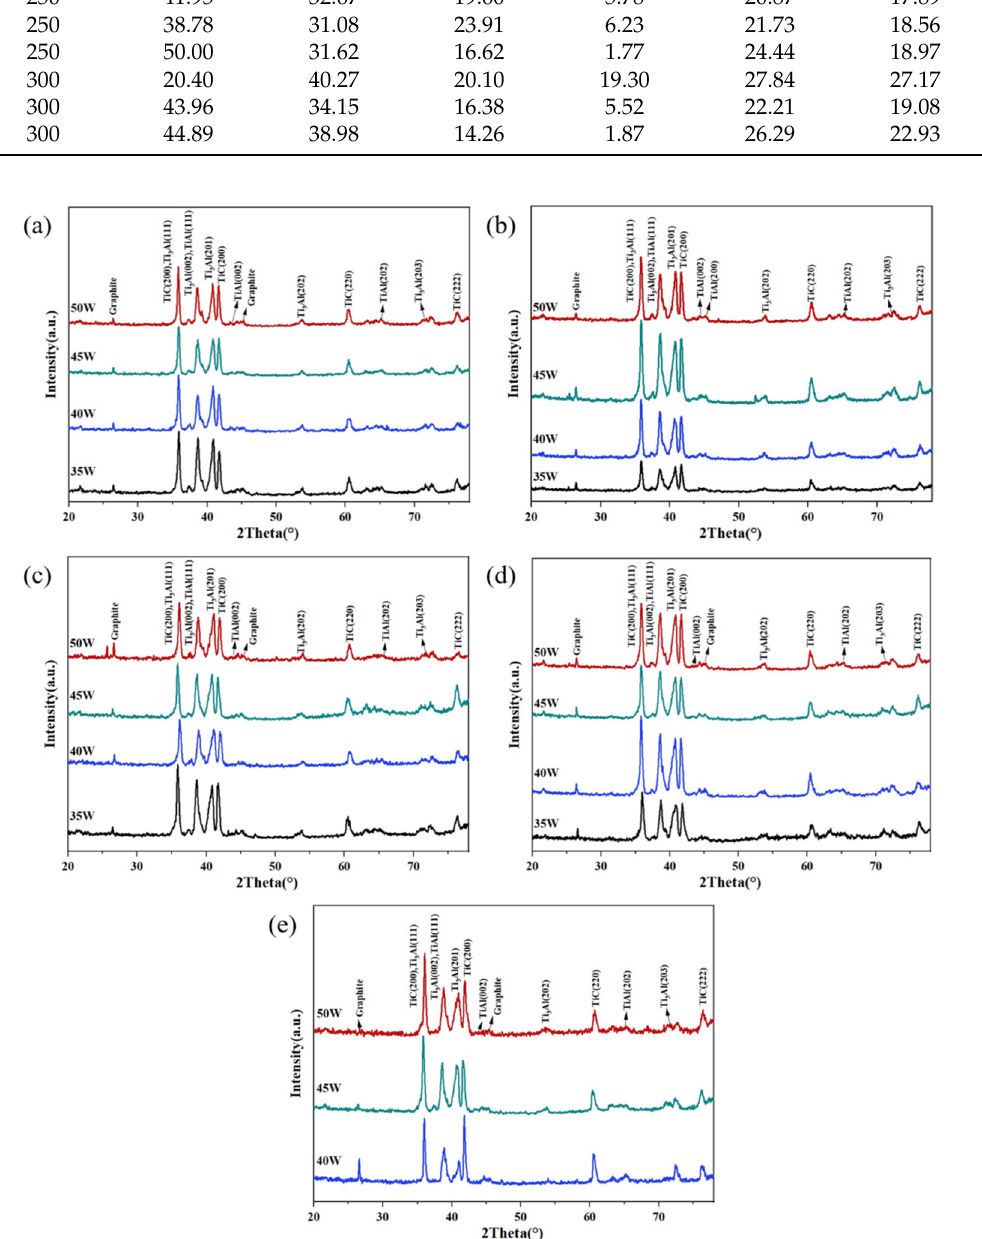
Figure 4. XRD results of ISLF samples with different process parameters: ( a ) 100 mm/s, ( b ) 150 mm/s, ( c ) 200 mm/s, ( d ) 250 mm/s, ( e ) 300 Table 2. Phases quantities of each phase in the ISLF sample, corresponding to different process pa- rameters.